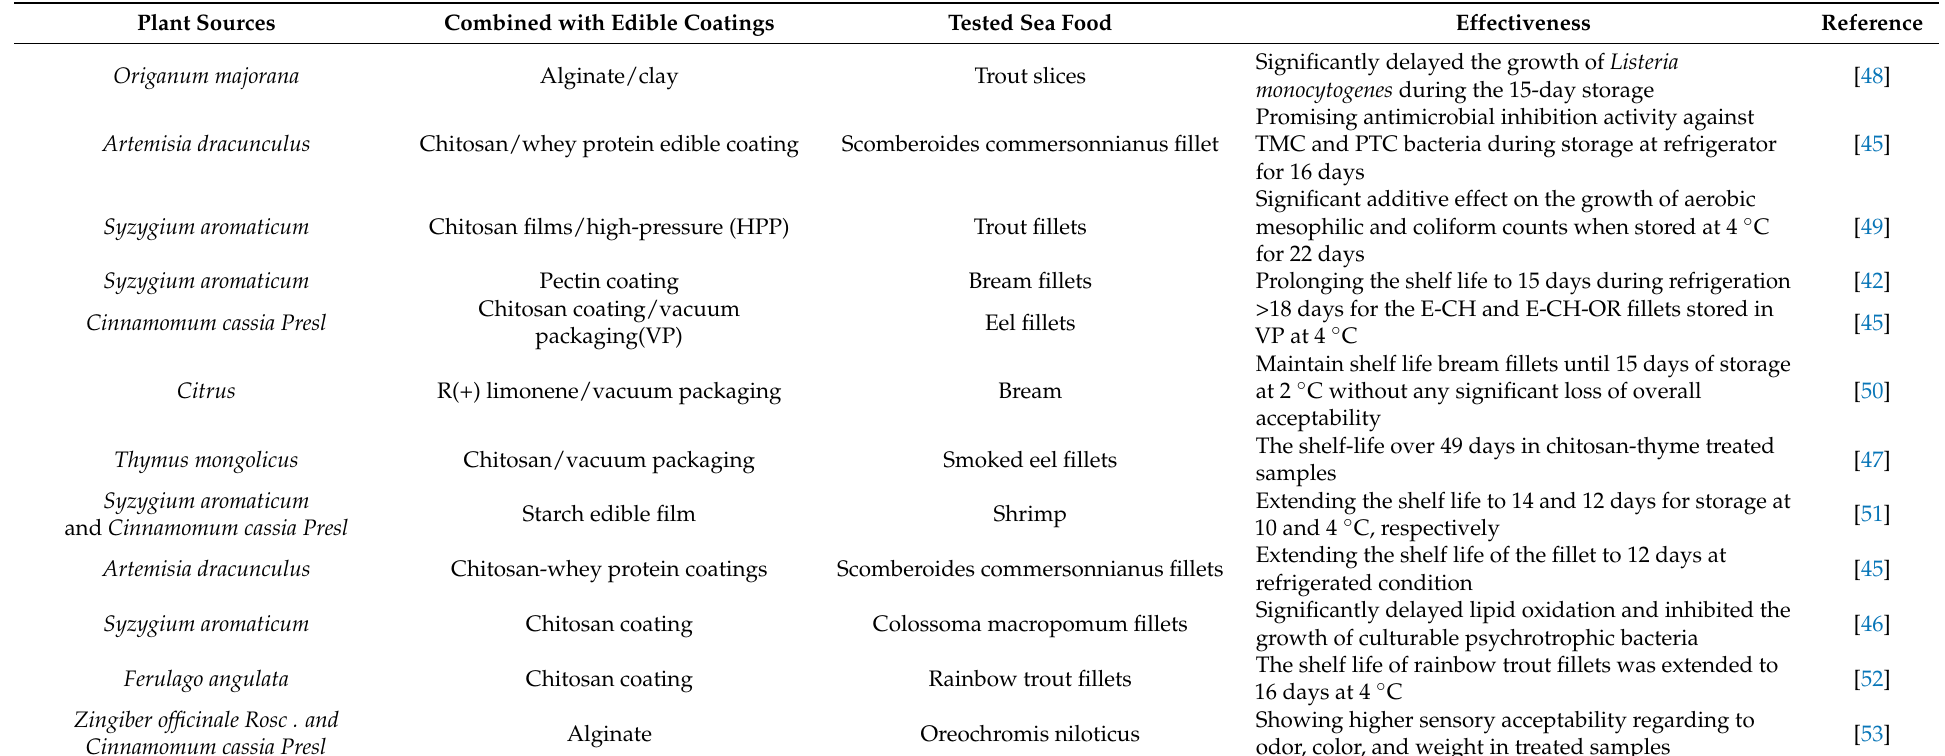
Table 2. Synergistic or additive effect of essential oils combined with active packing films on quality retention of seafood